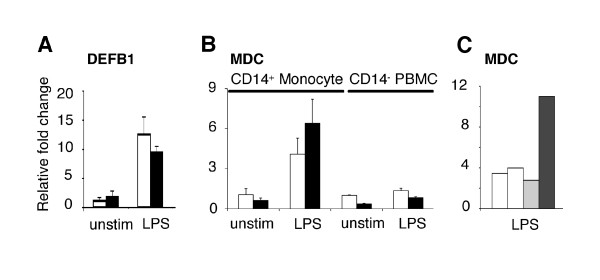
Strong expression of particular chemokines in IRAK4-deficient monocytes. The relative expression (Y-axis) of (A) DEFB1 and (B) MDC/CCL22 in IRAK4-deficient monocytes (black bars), controls (white bars) and for B) CD14- PBMC. Expression was measured in two independent experiments by real-time PCR following 4 hr incubation in the absence or presence of LPS (X-axis). C MDC/CCL22 in the tissue culture supernatant was measured by ELISA in IRAK4-deficient (black bars), adult (white bars) or age-matched (grey bars) PBMC. The result is representative of 2 independent experiments and the y-axis represents the relative fold change in protein after stimulation for 24 hr with LPS.